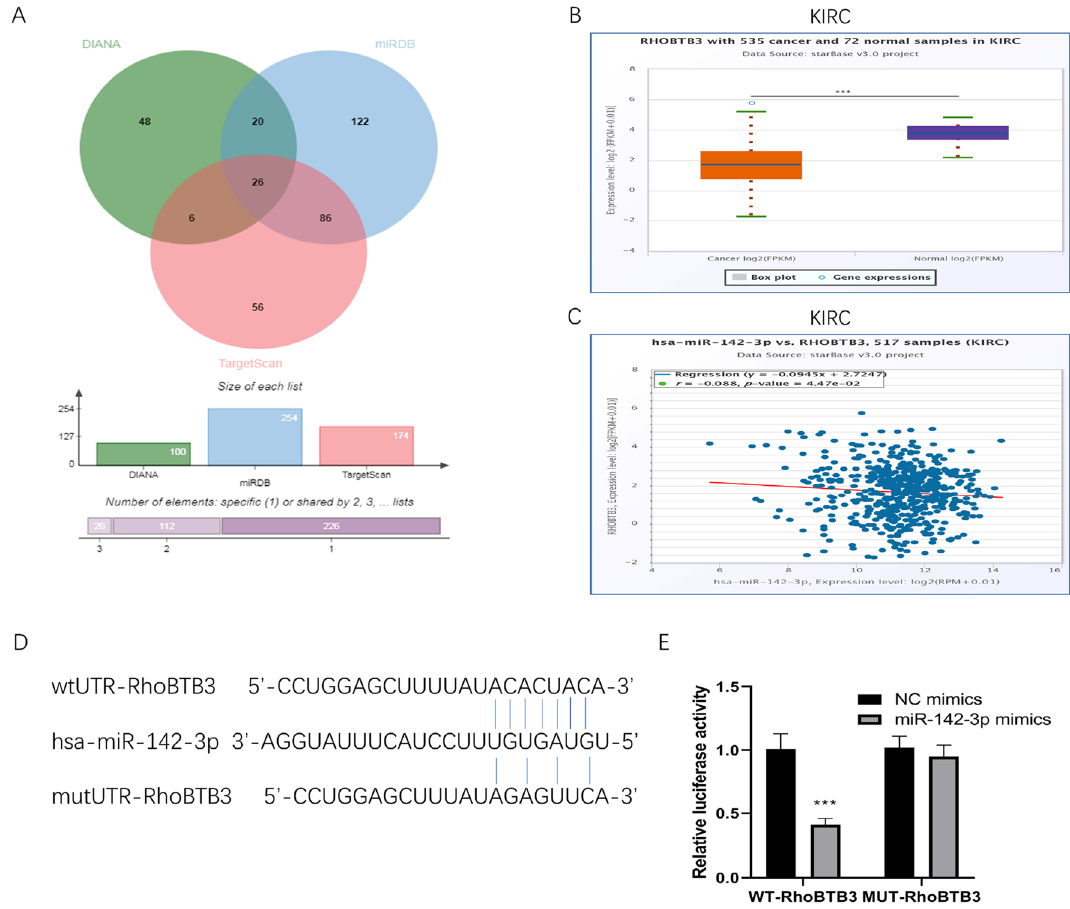
Figure 2. Database analysis of miR-142-3p and RhoBTB3. Venn diagram depicts the mRNA targets of miR- 142-3p predicted by three independent algorithms, Target Scan, DIANA, and miRDB ( A ). The expression